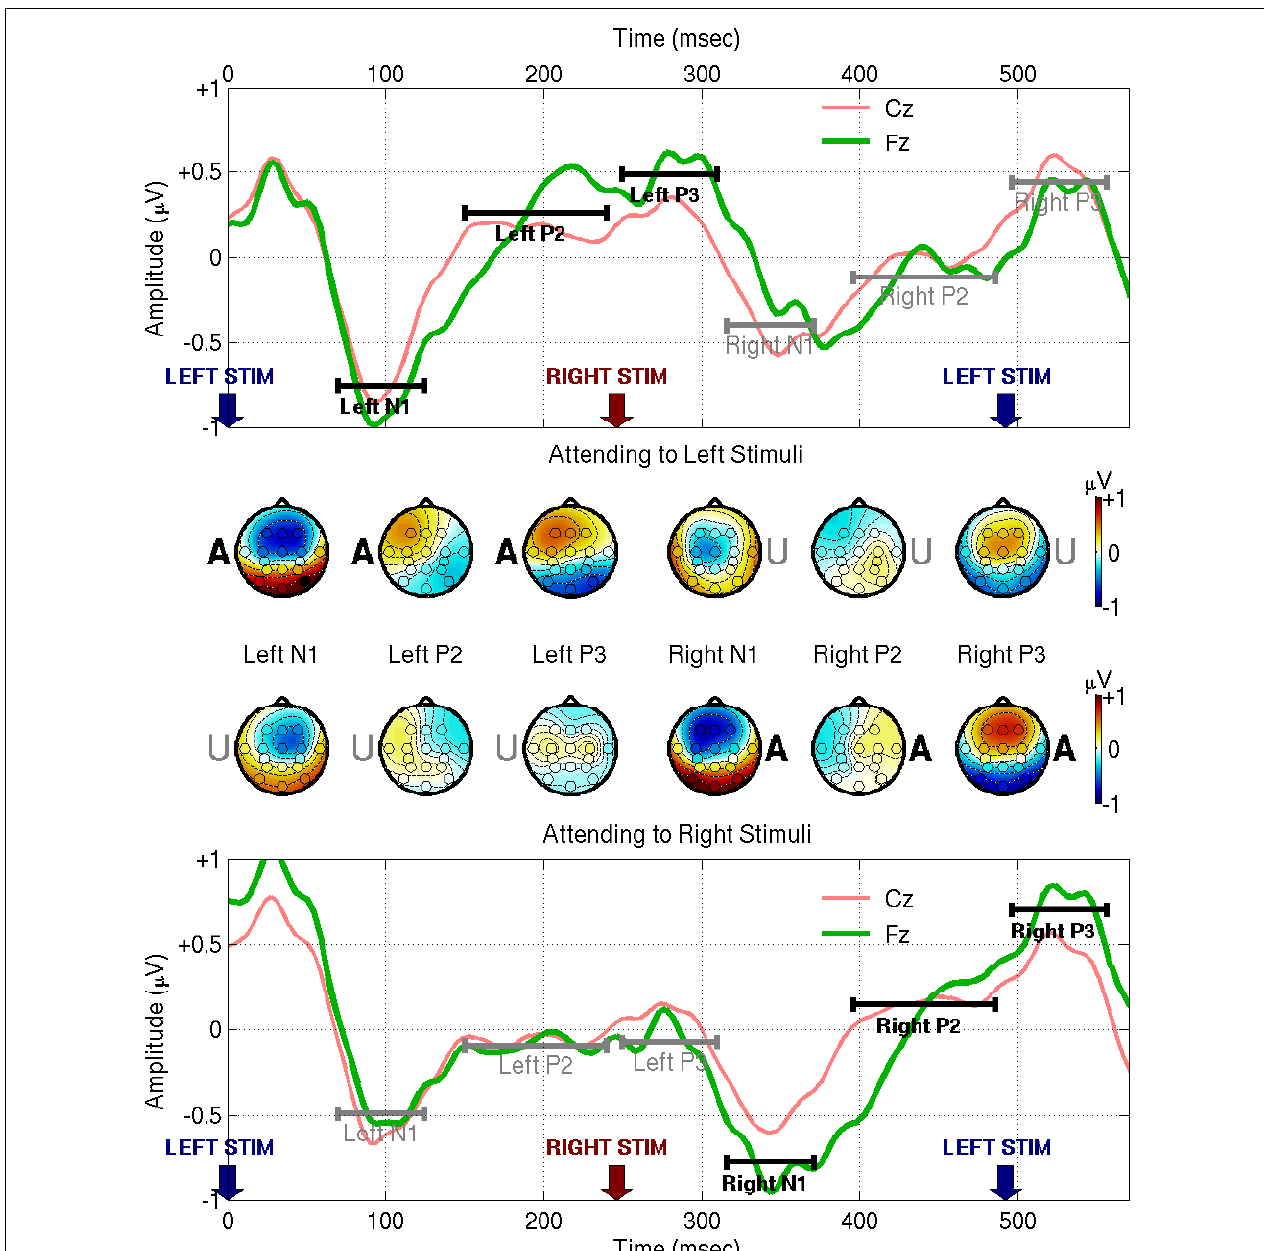
stimulus presentation is marked as N1, 150–240ms is marked as P2, and 250–310ms is marked as P3 (these numerical values were chosen based on the traces of Cz and Fz themselves, taking account of both electrodes, and both left- and right-attended stimuli). Scalp topographies were computed by averaging the signal within each of these ranges.The letters A and U appear at one or the other ear position on the scalp maps, to denote the ear in which the eliciting stimulus was delivered and whether it was [A]ttended or [U]nattended.